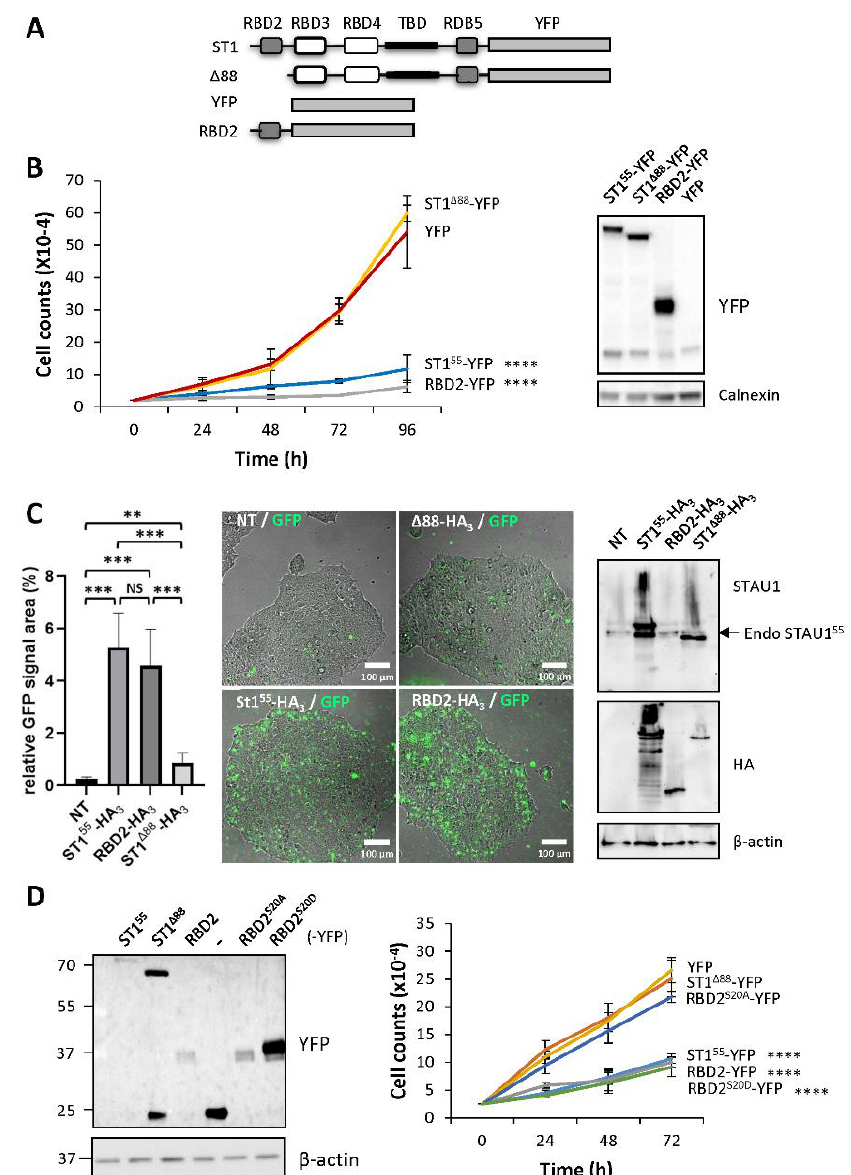
Figure 5. RBD2 expression impairs cell proliferation via serine 20. ( A ) Schematic representation of the expressed proteins. See legend of Figure 2. YFP, yellow fluorescent protein. ( B ) Cell proliferation assay. Transfected cells were trypsinized 24 h post-transfection, plated, and allowed to grow for four days. The graph represents the means and standard deviations of three independently performed experiments. ****, p - value ≤ 0.0001 (Tukey’s multiple comparisons ANOVA test). Western blots (right panel) showing the expression of the proteins. ( C ) HEK293T cells were transfected with plasmids coding for STAU1 55 -HA 3 , STAU1 Δ88 -HA 3 , and RBD2-HA 3 and were immediately incubated in the presence of the GFP-coupled apoptosis stain. ( Left ) Quantification of the GFP signal. The graph represents the means and standard deviations of three independently performed experiments. **, p - value ≤ 0.01. ***, p - value ≤ 0.001 (Student t -test). NS, not significant. ( Right ) Western blots showing the expression of the proteins. The blots are representative of three independent experiments that gave similar results. Endo STAU1 55 , endogenous STAU1 55 . ( D ) Cell proliferation using growth curve assays was quantified over three days. The graph represents the means and standard deviations of three independently performed experiments. ****, p - value ≤ 0.0001 (Tukey’s multiple comparisons ANOVA test). Western blots (left panel) showing the expression of the proteins.